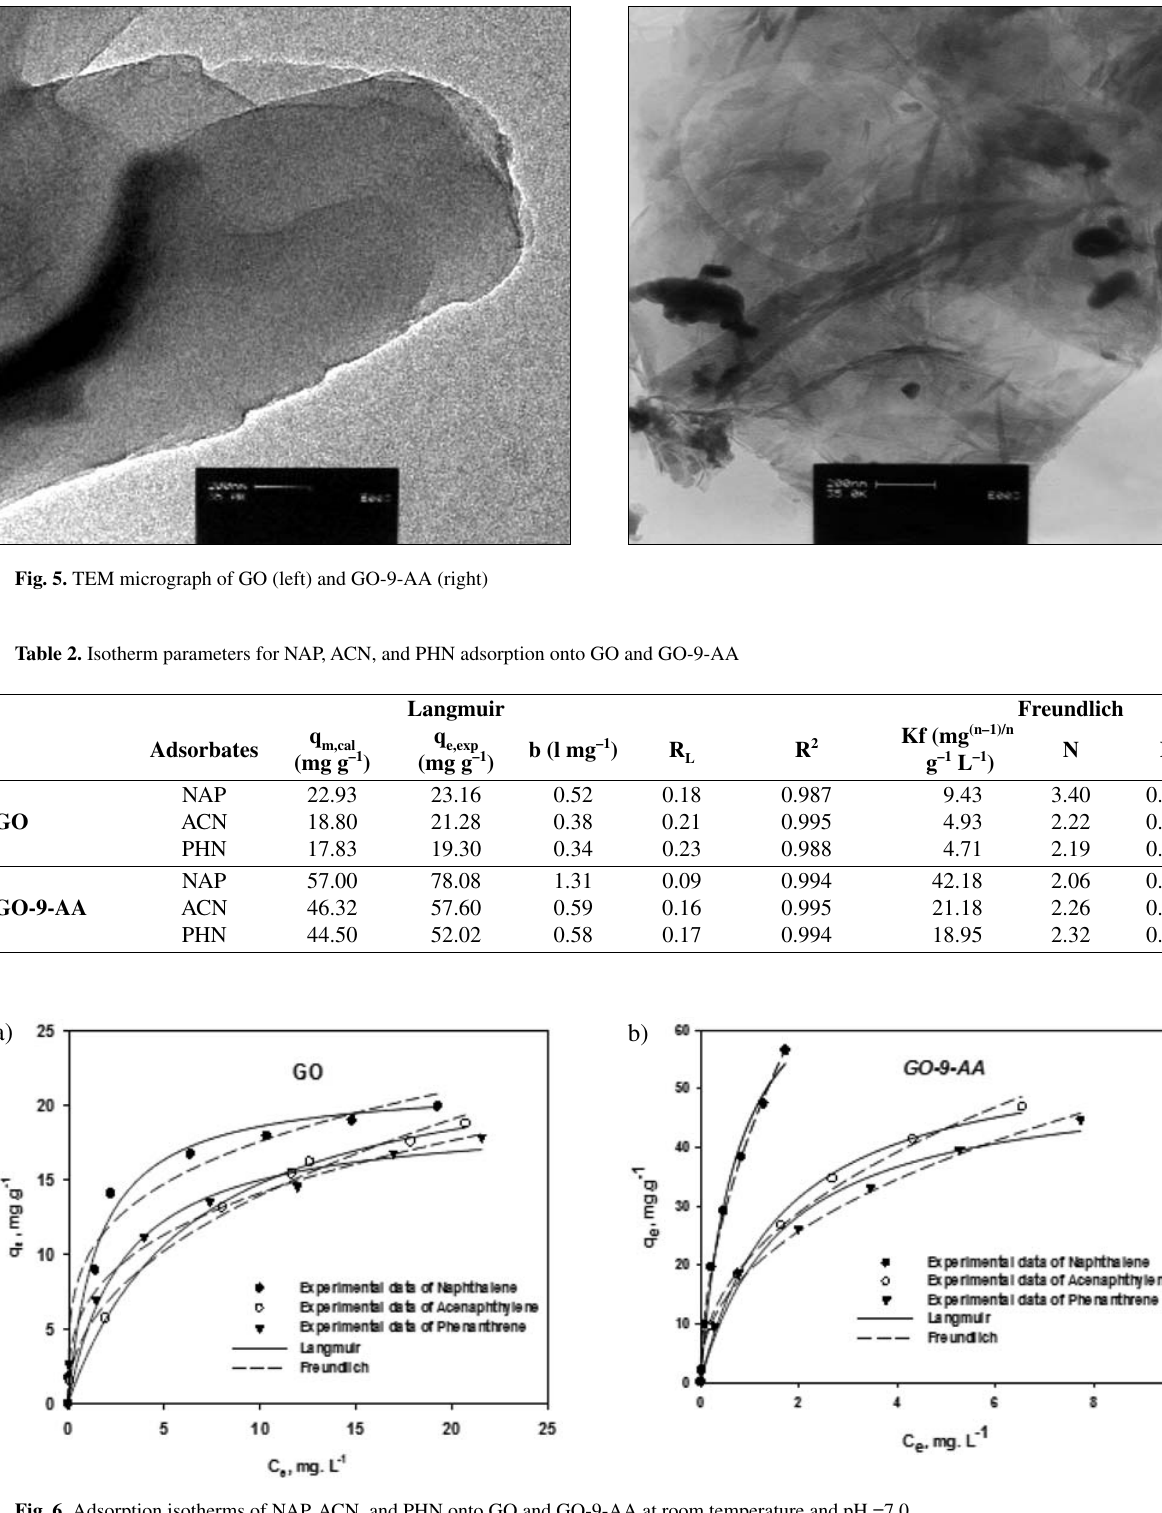
Fig. 6. Adsorption isotherms of NAP, ACN, and PHN onto GO and GO-9-AA at room temperature and pH =7.0